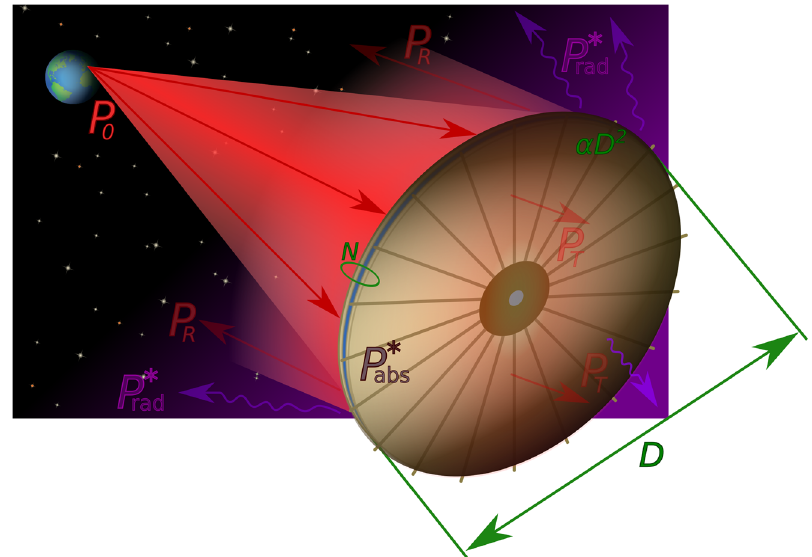
Fig. 1 Representation of the operation conditions of the multilayered lightsail. The red arrows denote the incident, transmitted and re fl ected laser power, while the violet ones indicate the thermal radiation leaving the structure from the front and back surfaces. The surface area is modeled as α D 2 ; α = 1 for a squared lightsail of side D and α = π /4 for a circular lightsail of diameter D